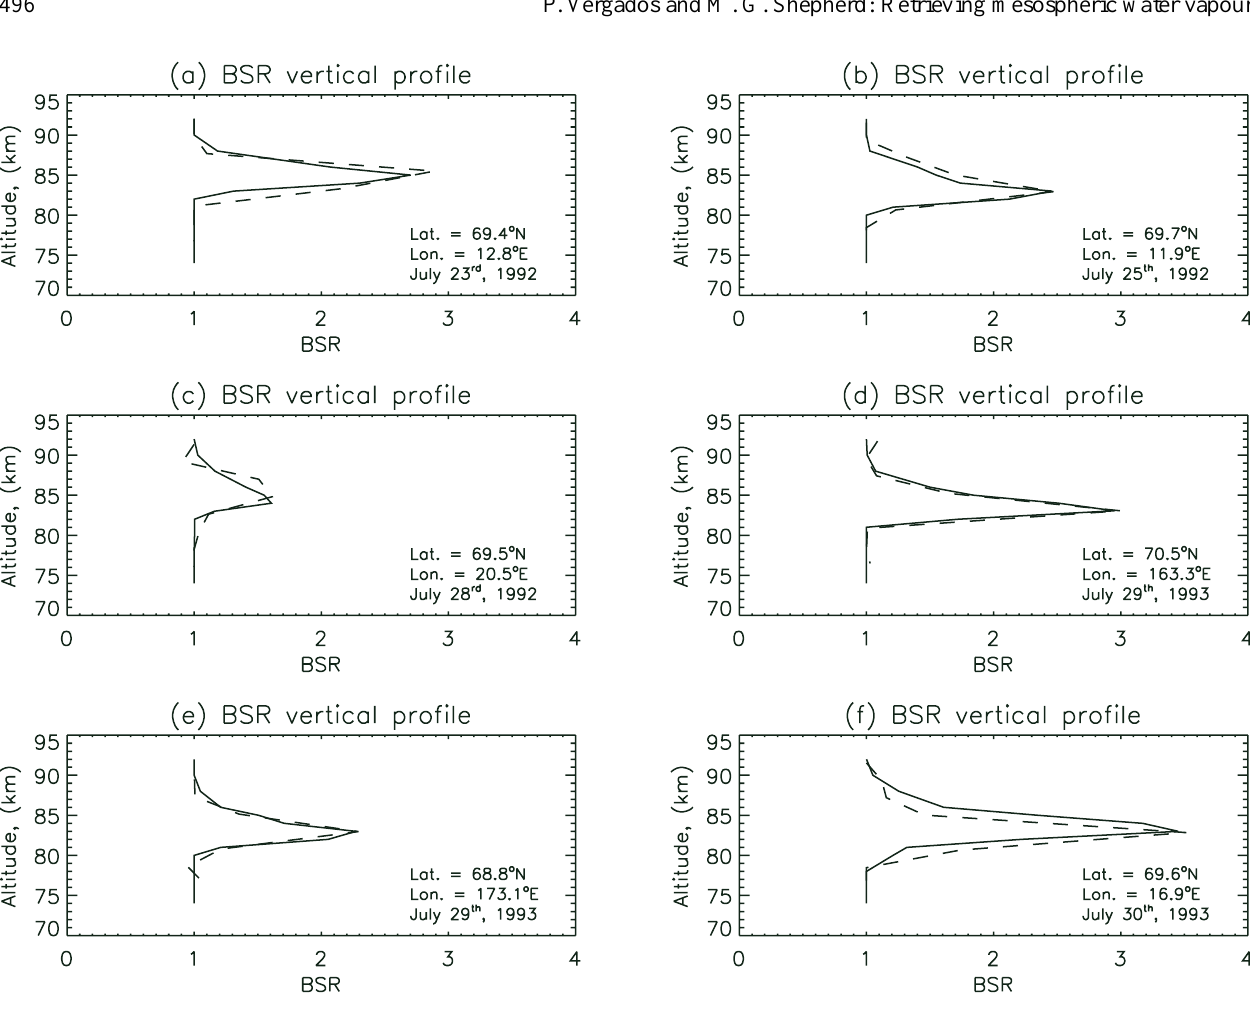
Fig. 5. (a–f) The modelled and observed BSR profiles according to the WINDII data. The solid and dashed lines give the modelled and the observed BSR,